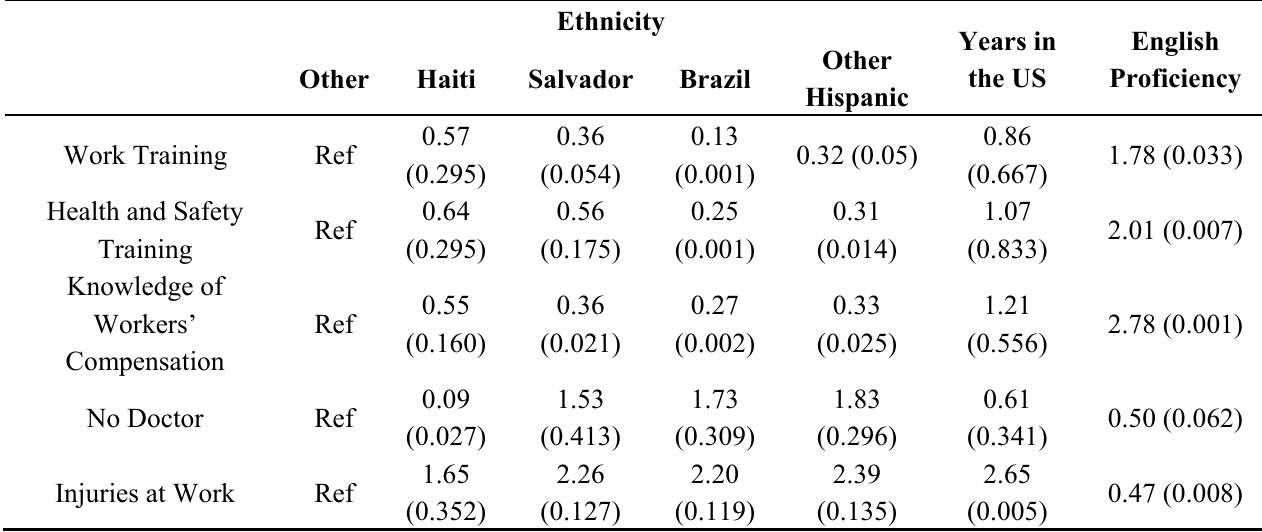
Table 4. Odds ratio and P values by ethnicity, years in the US and English